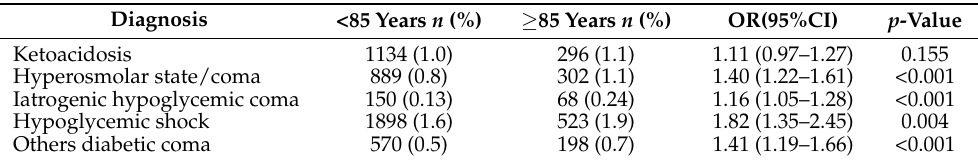
Table 2. Logistic regression analysis showing the association between age over 85 years and short- term diabetes-related complication